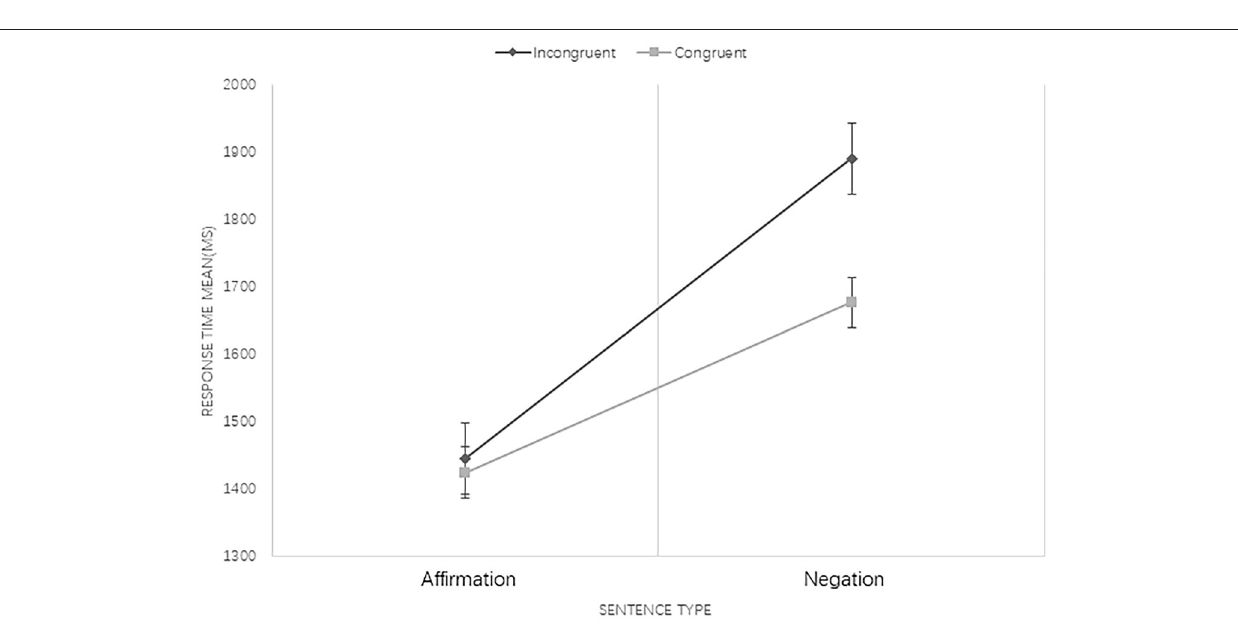
were processed (see Figure 2 ). The interaction between language type and congruency condition was not significant [ F (1, 308) = 0.267, p =